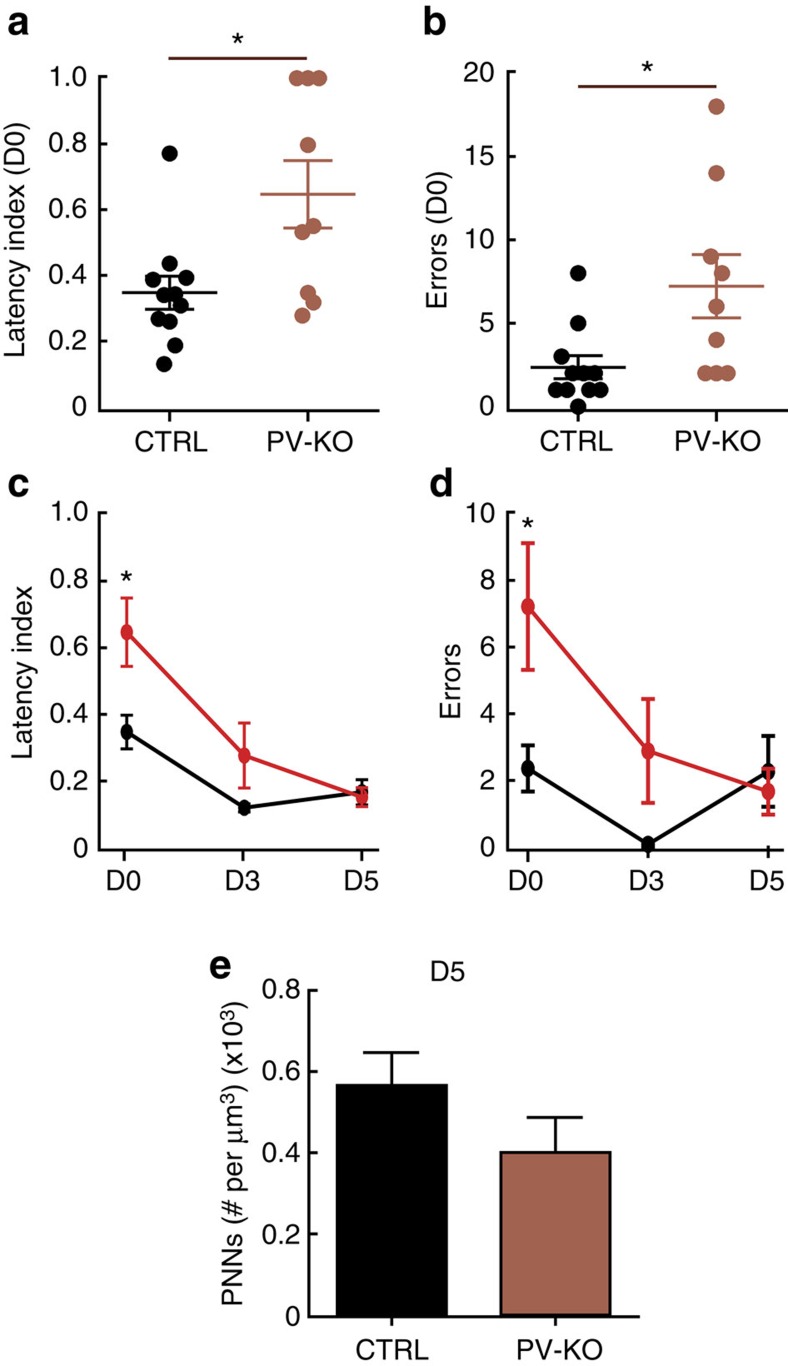
Knocking out Mecp2 in PV neurons affects early learning.(a–d), Mice with PV cells lacking MECP2 (PV-KO) behaved significantly worse than their control littermates (CTRL) at Day 0 (D0) by measure of latency (a,c) and errors (b,d) (CTRL: N=11 mice; PV-KO: N=9 mice; At D0: Latency: Mann–Whitney, *P=0.020; errors: Mann–Whitney, *P=0.010). However, PV-KO mice behaved equally as well as their control littermates at Day 3 and 5 (D3 and D5, respectively (c,d; Mann–Whitney, P>0.05). Lines represent mean±s.e.m. (e) Density of high-intensity PNN+ cells were comparable between PV-KO mice and their control littermates accessed at Day 5 (D5) (CTRL: n=514 PNN+ cells, 36 images, 9 mice; PV-KO: n=344 PNN+ cells, 34 images, 9 mice; Mann–Whitney, P=0.064). Bar graphs represent mean±s.e.m.